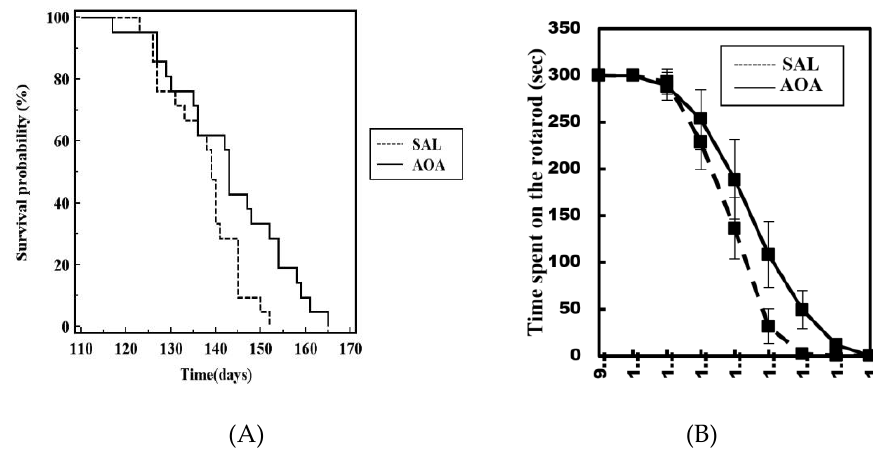
Figure 1. Combined Kaplan–Meier survival curve of male and female SOD1G93A. The survival curve shows a tendency toward an increase in the life span in the female group. Survival curves are not statistically significant ( A ). Treatment with AOA also had no significant effects on the rotarod test ( B ).